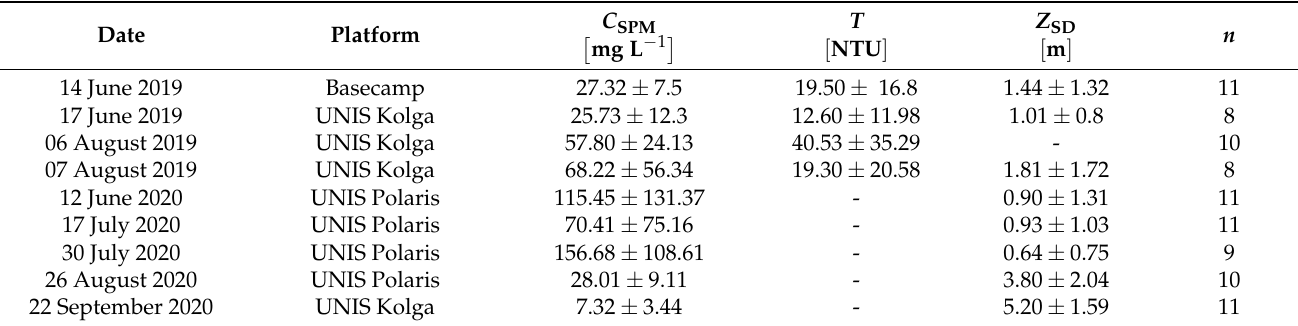
Table 1. Summary of performed in-situ sampling during the 2019 and 2020 summer campaigns. Averaged values ( ± SD) are given for suspended particulate matter ( C SPM ), turbidity ( T ), and secchi depth ( Z SD ) at n stations sampled. In 2020, turbidity was not